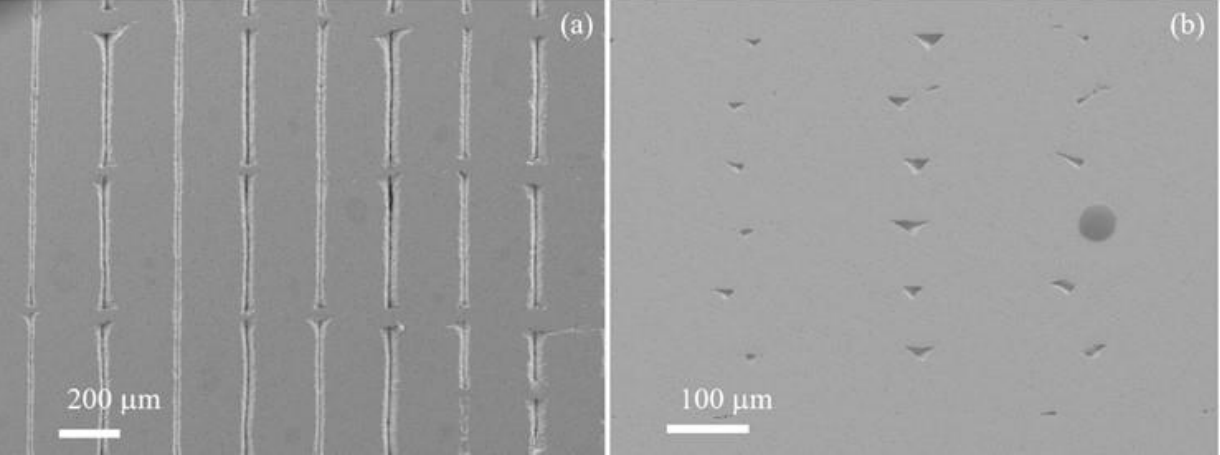
Figure 6. ( a , b ) SEM images of the as-printed sample surface structures from two perspectives.